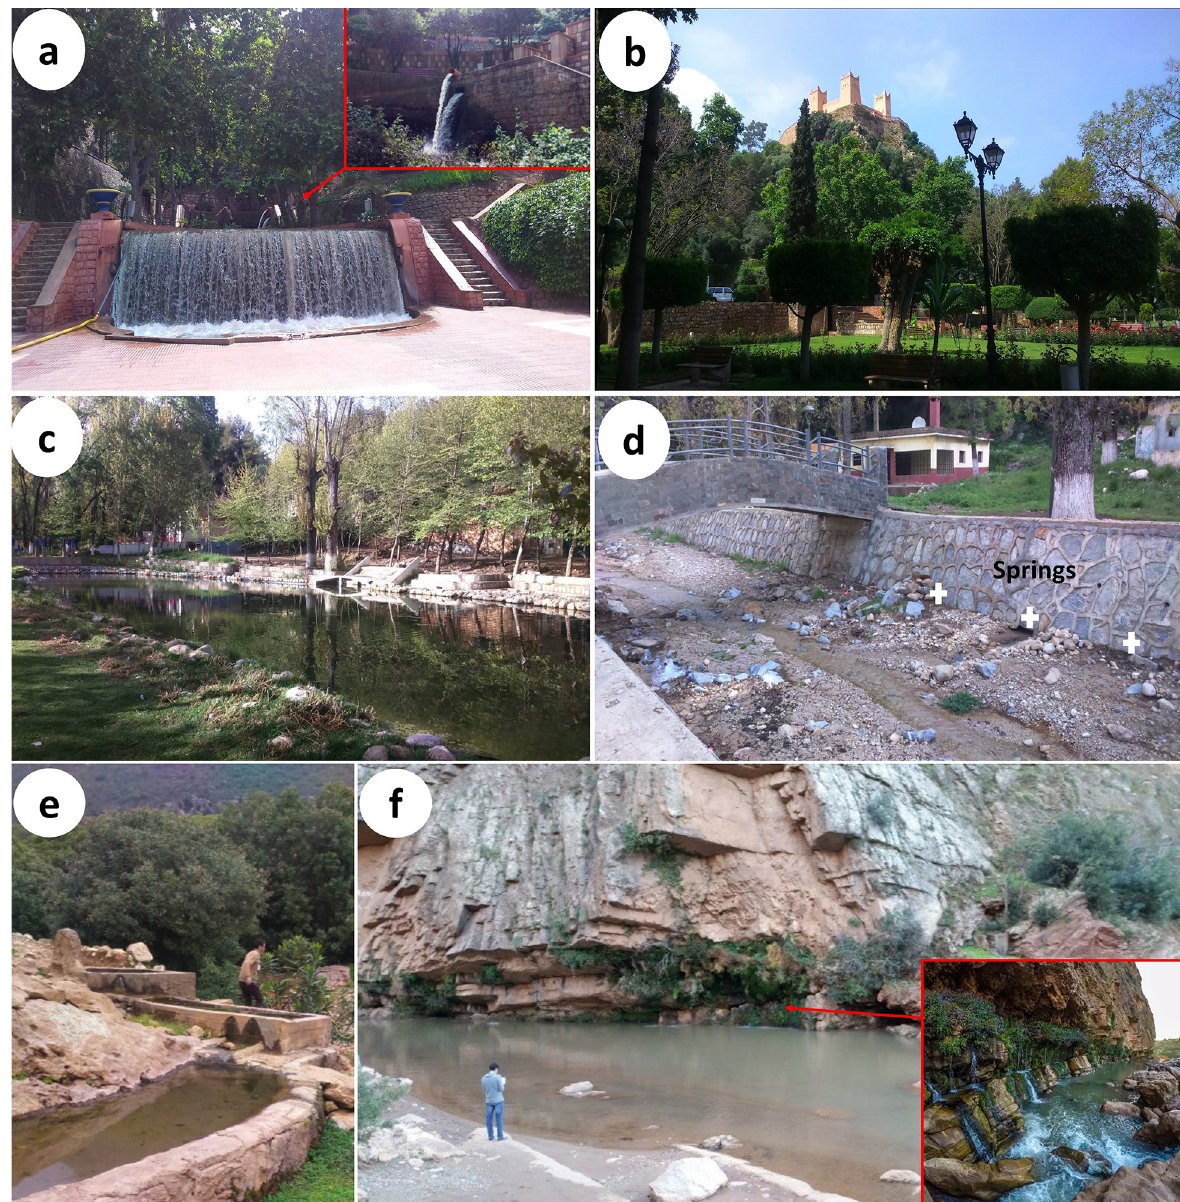
Fig. 4. The most springs visited by tourists and hikers. (a, b) Spring of Ain Asserdoune. (c), (d) Spring of Taghbalout Ouhlima. (e) Spring of Tamoudjout. (f) Springs of